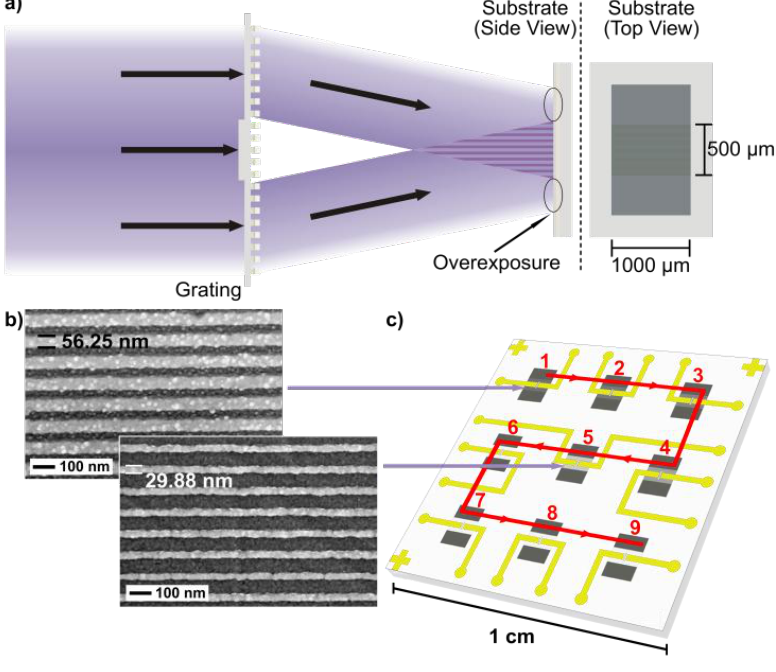
Figure 1. An illustration of a realistic EUV-IL exposure. A PMMA resist on an Nb coated wafer is exposed to light diffracted by an e-beam fabricated grating. The grating-dependent periodicity of the resulting interference pattern here is 100 nm. The result is a chip with nine exposed regions, which is illustrated in (c) as the end product of the complete nano- and microfabrication. The varying exposure times in each region yield nine regions with varying line widths. Region one has the widest openings in the PMMA ( i.e. , the widest lines after fabrication) as shown in (b) , while region nine has the thinnest openings. The illustration (c) shows a typical nanowire fabrication in only five regions, since the dose of certain exposures is not strong enough to expose the photoresist to the substrate surface. Thus, the line pattern disappears upon photoresist removal, yielding no lines in such regions. On such a typical sample the thinnest continuous wires would exist in a middle region, such as region